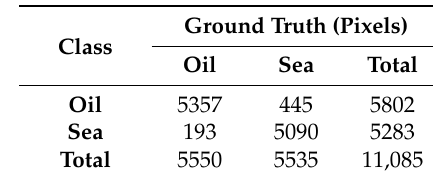
Table 8. Confusion matrix achieved by SVM based on 9 dual-polarized (DP) mode features.